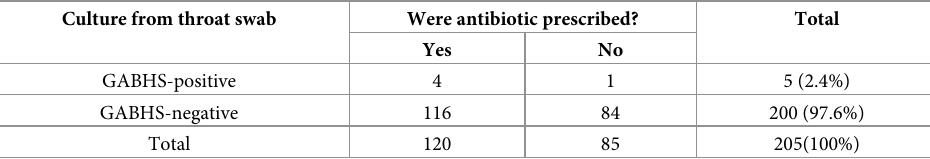
Table 6. Antibiotic prescription based on culture from throat.